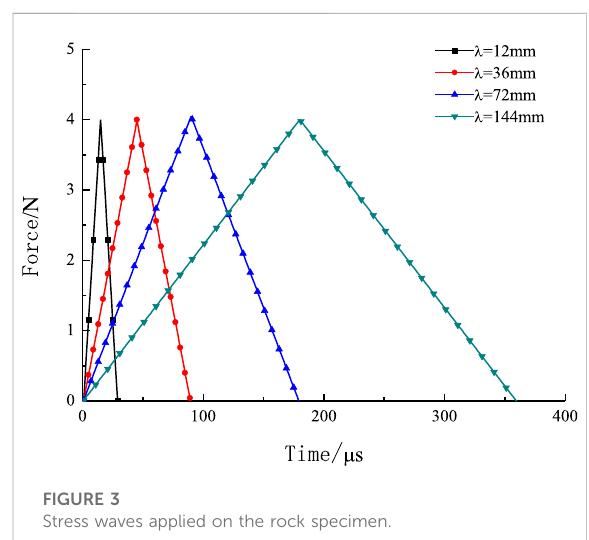
FIGURE 3 Stress waves applied on the rock specimen.